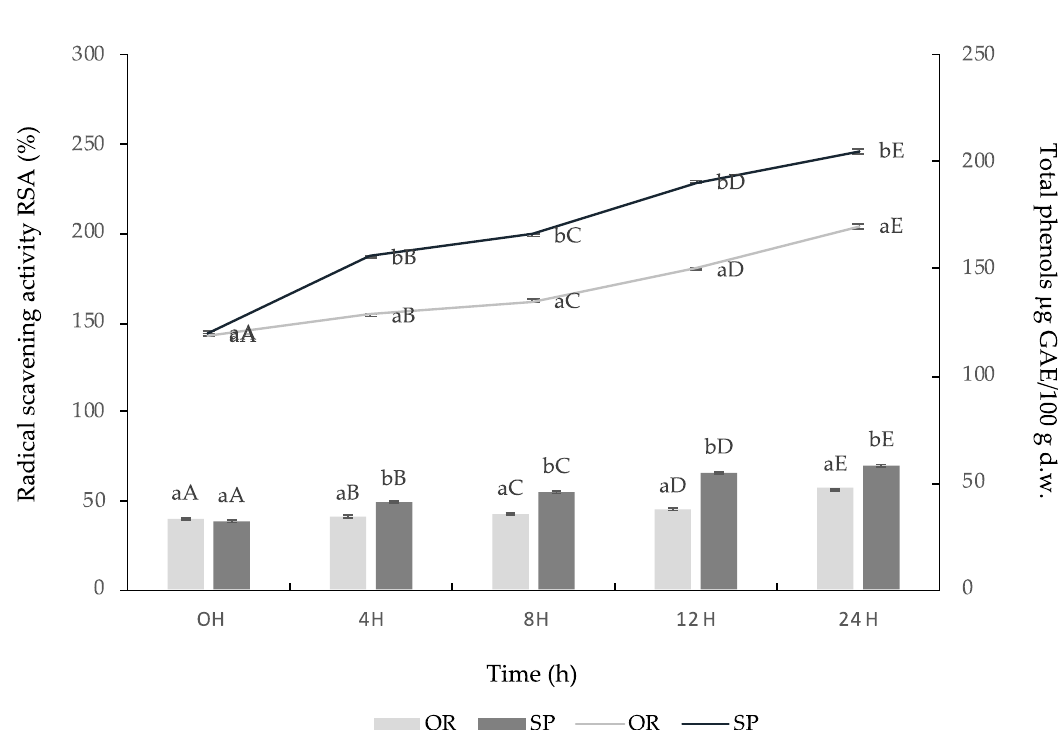
Figure 3. Phenolic compounds content of methanolic extracts during 0, 4, 8, 12, 24H of fermentation in inoculated (SP) and non-inoculated (OR) sourdoughs with L. spicheri DSM 15429, (Values not sharing the same small letters indicate the significant di ff erence between OR and SP at di ff erent moments: 0, 4, 8, 12, 24H; Values not sharing the same capital letters indicate the significant di ff erence between OR and SP at the same moments: 0, 4, 8, 12, 24H); d.w., dry weight.